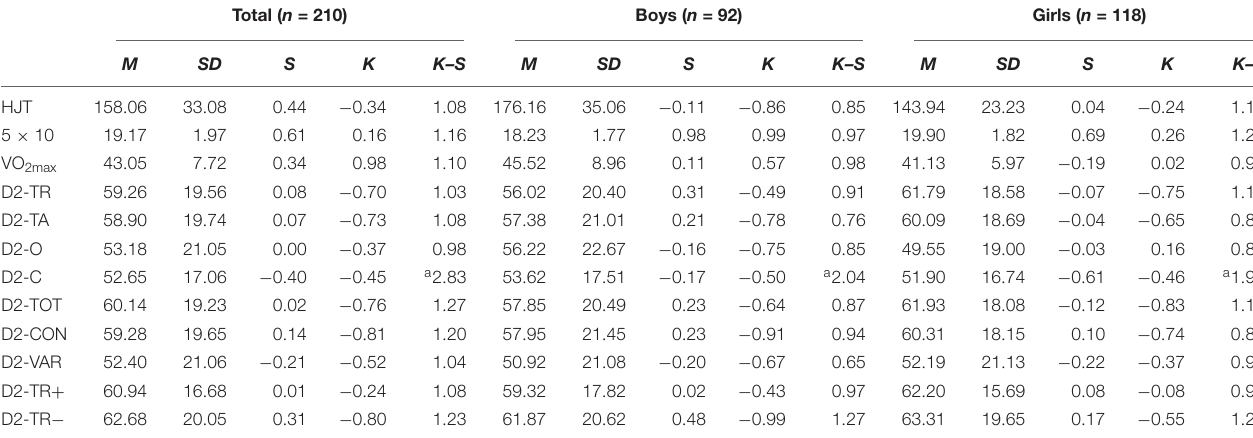
TABLE 1 | Descriptive statistics of study variables and Kolmogorov–Smirnov test.